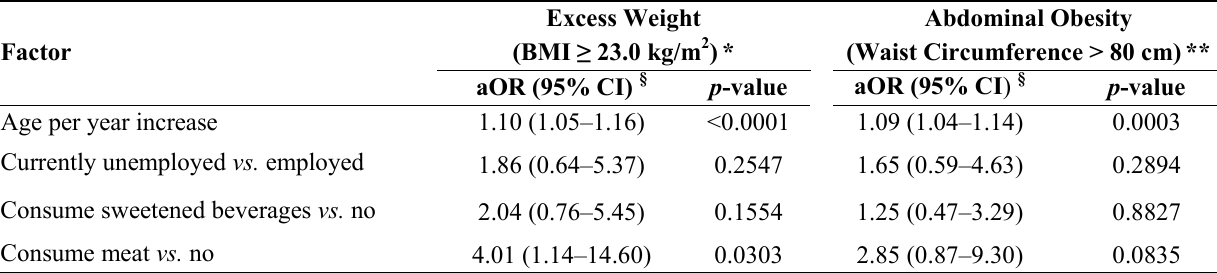
Table 3. Multivariable logistic regression analyses of factors associated with excess weight (body mass Index (BMI) ≥ 23.0 kg/m 2 ) and abdominal obesity (waist circumference > 80 cm) among 18–65 year old Bhutanese refugee women in Northeast Ohio, United States, 2011 (n =